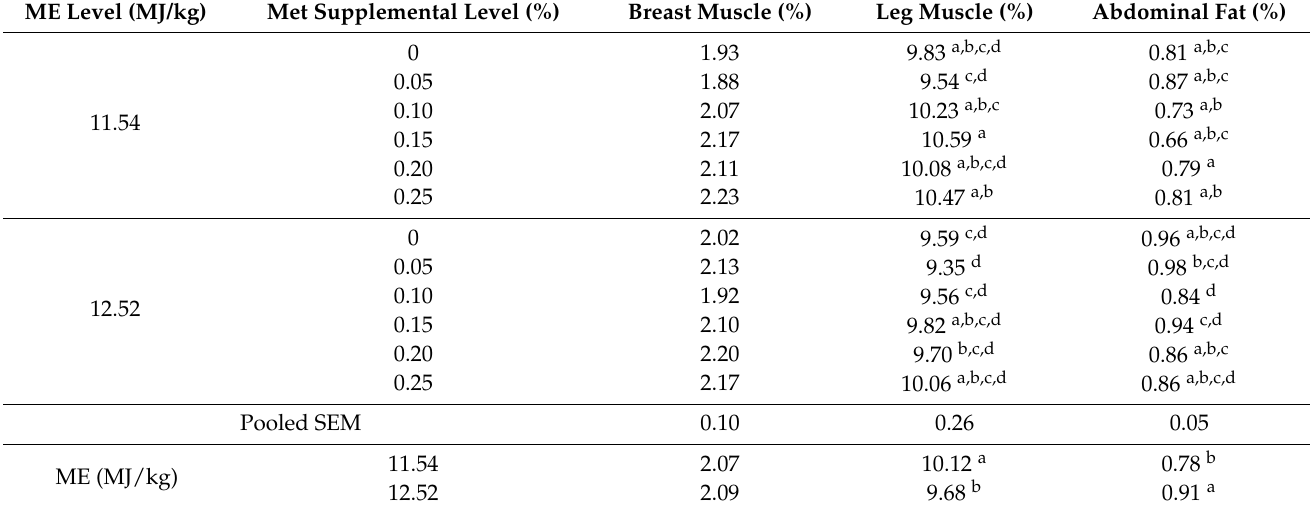
Table 4. Effects of dietary metabolizable energy and methionine levels on carcass characteristics of starter Pekin ducks at 21 days of age 1,2